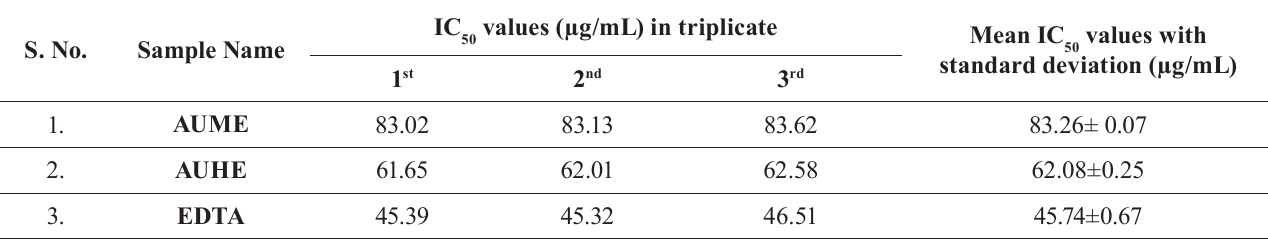
TABLE IV - IC value of metal chelating activity of plant extracts of whole plant of A. uliginosa 50